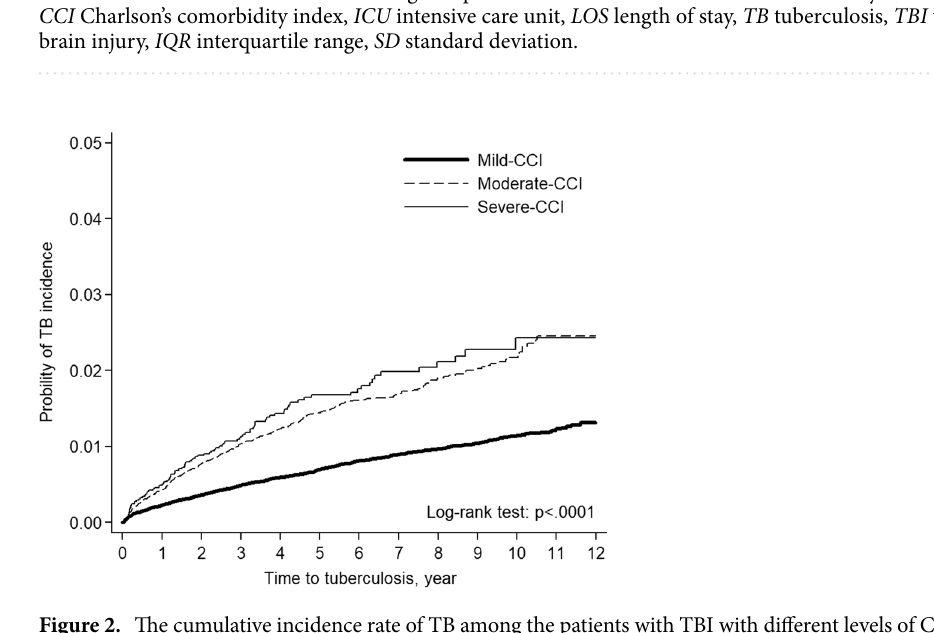
Figure 2. The cumulative incidence rate of TB among the patients with TBI with different levels of